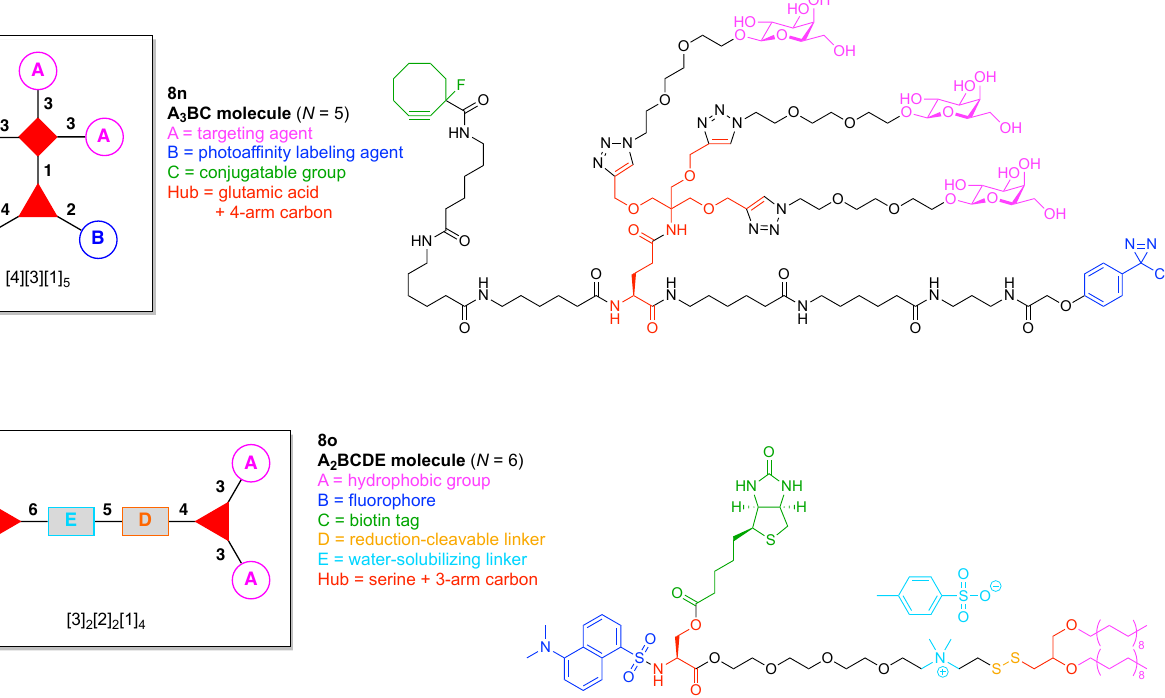
Figure 30. Two examples each with two hubs including one amino acid. A NIR fluorescent probe bearing tetrameric RGD peptides ( 8p ) was developed for optical tumor imaging (Figure 31) [175]. The probe is comprised of three Glu hubs and two functional components: (A) the cyclic peptide cyclo (-Arg-Gly-Asp- D -Tyr-Lys-) as a targeting agent for integrin α v β 3 , which is significantly up-regulated in activated endothelial cells and fast-growing solid tumor cells, and (B) the pentamethine cyanine dye Cy5.5 as a fluorophore. This construct ( 8p ) has composition A 4 B and architecture [3] 3 [1] 5 . A fully synthetic, pentavalent carbohydrate-based system ( 8q ) was developed as an antitumor vaccine (Figure 31) [176]. The vaccine contains four 6-hydroxy norleucine (Nle(6-OH)) hubs and six functional components, of which five are antigens: (A) a Tn antigen; (B) a TF antigen; (C) a sialosyl-Tn antigen; (D) the Lewis y antigen, and (E) the Globo-H antigen, each of which is overexpressed on prostate and breast cancer cell surfaces. The sixth functional component, (F), is keyhole limpet hemocyanin [8] as an immunogenic carrier protein. This construct ( 8q ) has composition ABCDEF and architecture [3] 4 [1] 6 .